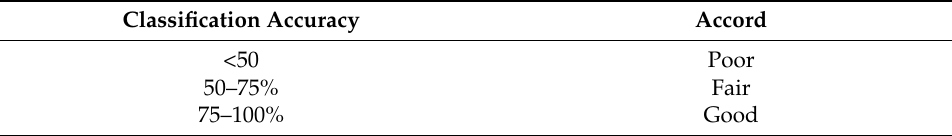
Table 1. Evaluation grid of the